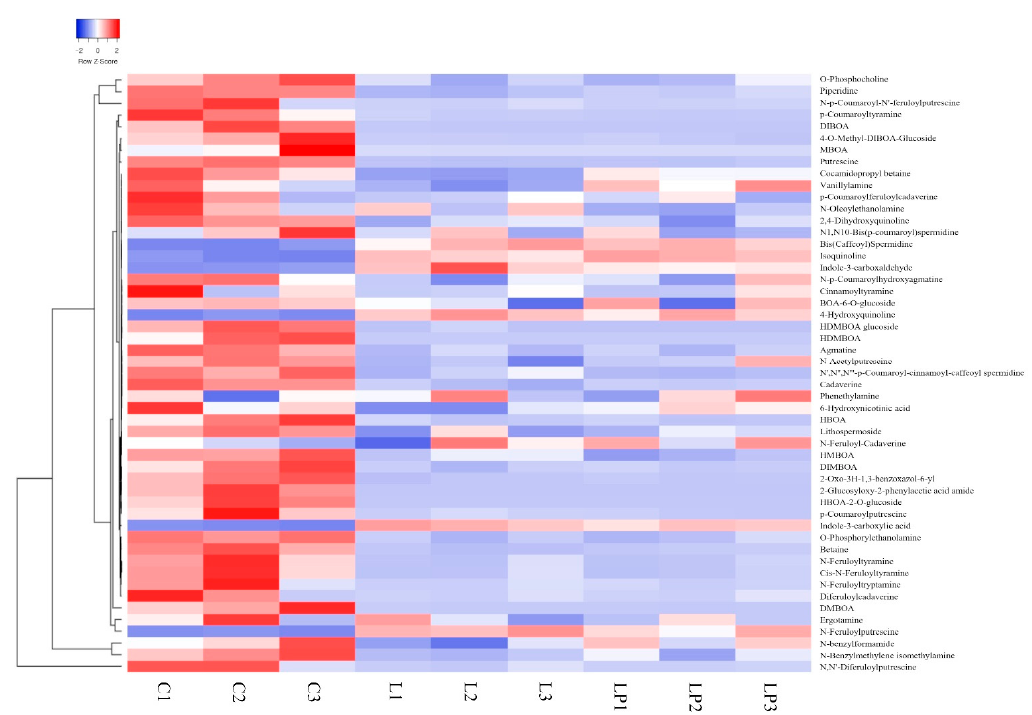
Figure 16. Heatmap and dendrogram of alkaloids metabolites in embryos of maize under exogenous proline and low-temperature stress treatments. Phenols Metabolites